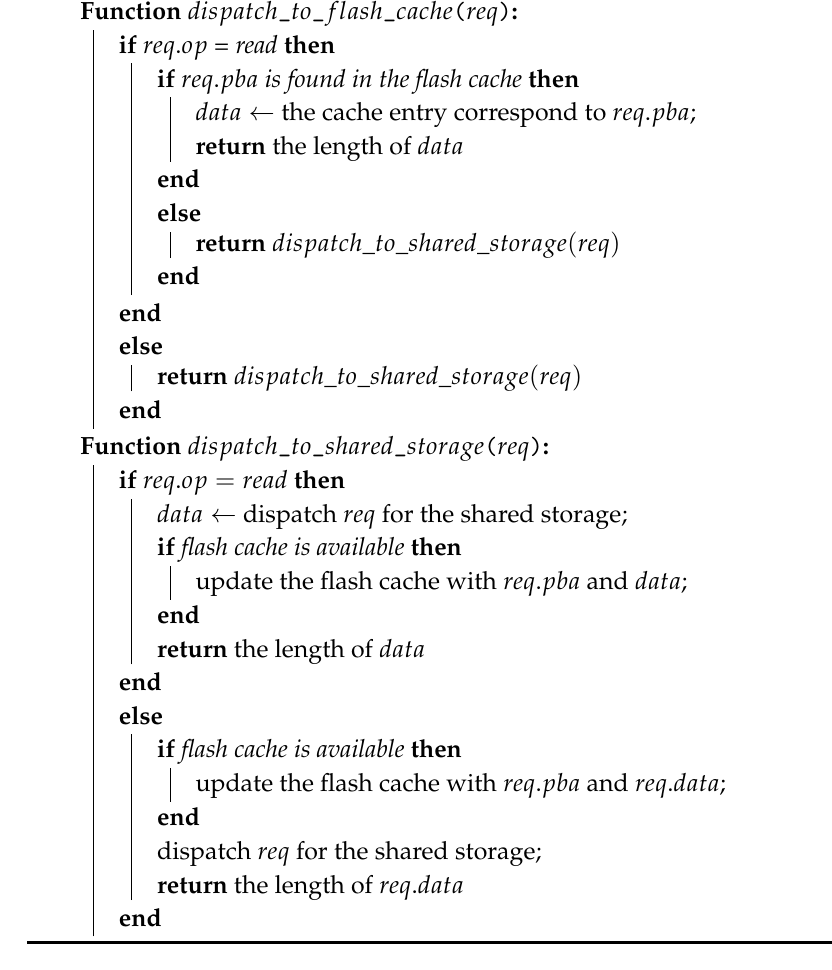
Algorithm 2: Dispatch functions for the flash cache and the shared